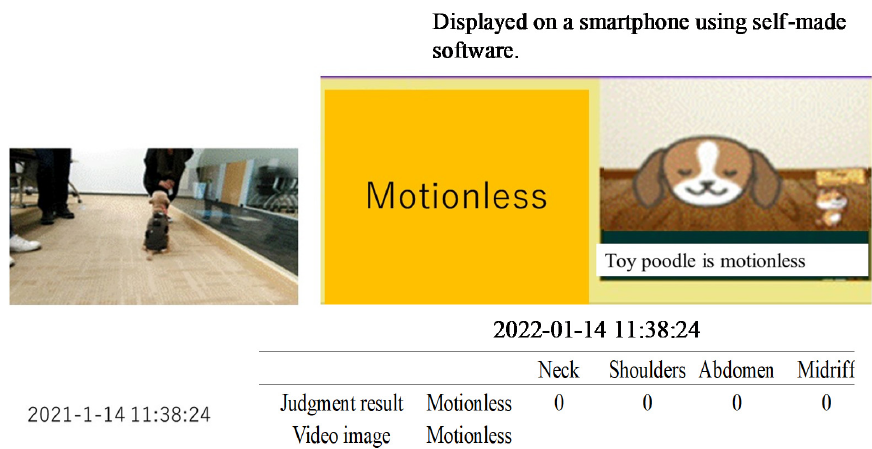
Figure 16. Example of match between the judgment result and the video image.